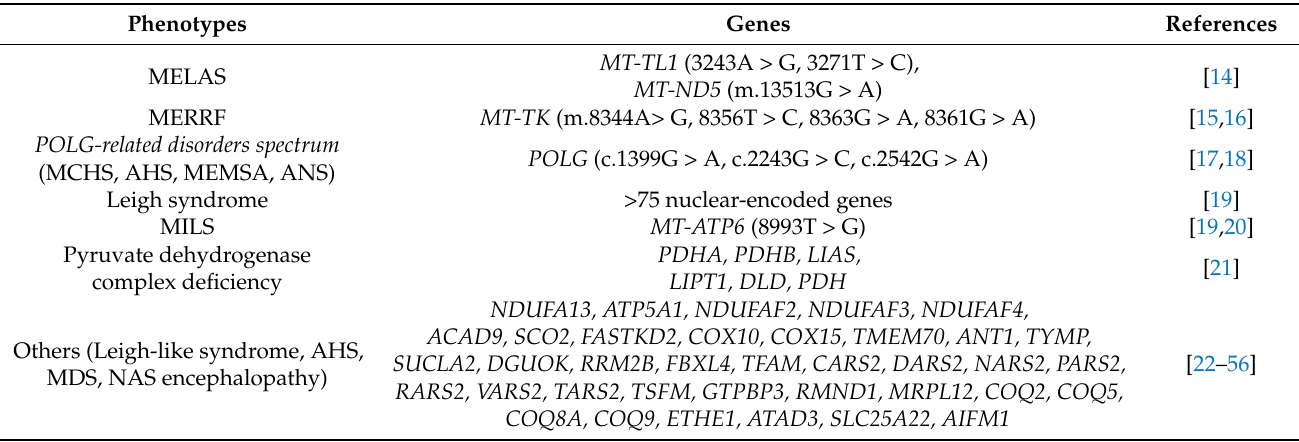
Table 1. Gene defects and phenotypes associated with mitochondrial